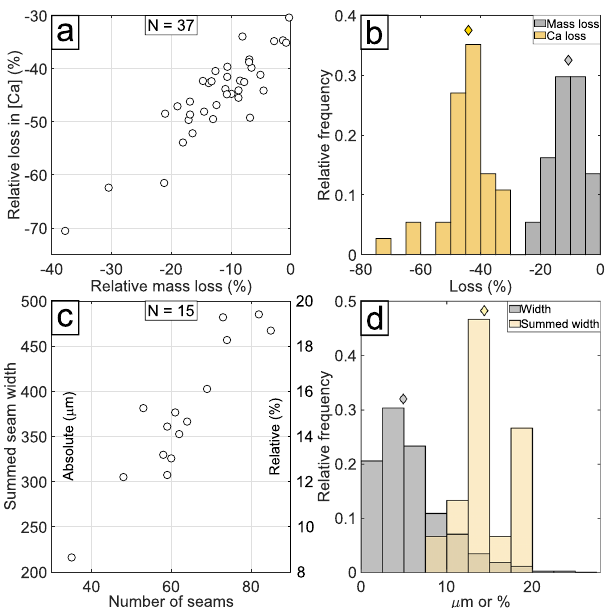
Fig. 6 Results of the mass-balance and scan-line analyses for Sample B. a Plot of the relative decrease in Ca concentration over relative total mass loss within micro-dissolution seams. b Histograms of the relative frequencies of the quantities plotted in ( a ). The diamonds above the histograms indicate the median. c Plot of total cumulative distance along a scan-line occupied by dissolution seams in absolute and relative values (compared to total scan-line length, right ordinate) over the total number of seams intercepted by a scan-line. d Relative frequency distribution of the absolute widths of individual dissolution seams (in μ m, grey bars) and the relative cumulative width of dissolution seams along a scan-line (in %, yellow bars). The diamonds indicate the medians. The data used to make this fi gure are provided in Supplementary Data